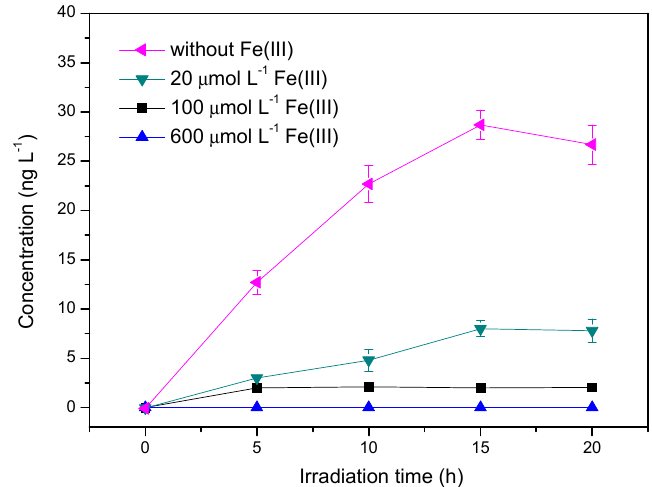
Figure 8. Effect of Fe(III) on the production of methyl chloride. Reaction conditions: light intensity = 12 mW cm − 2 . [Cl − ] = 0.5 mol L − 1 , [HA] = 5 mg L − 1 , pH = 4.0.